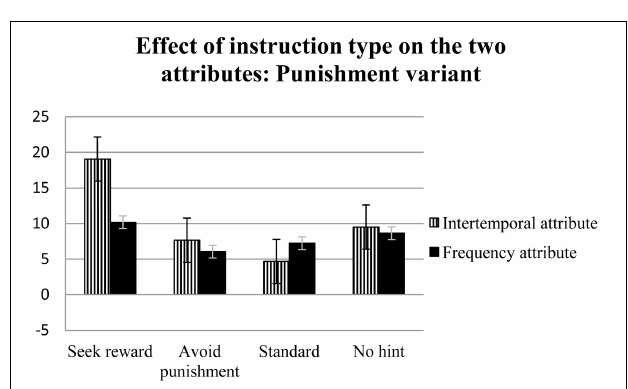
FIGURE 1 | The effects of four types of instructions on decision making in the reward variant, assessed via two attributes: intertemporal (C (cid:2) + D (cid:2) )—(A (cid:2) + B (cid:2) ) and frequency (B (cid:2) + D (cid:2) )—(A (cid:2) + C (cid:2) ). Error bars represent standard errors.